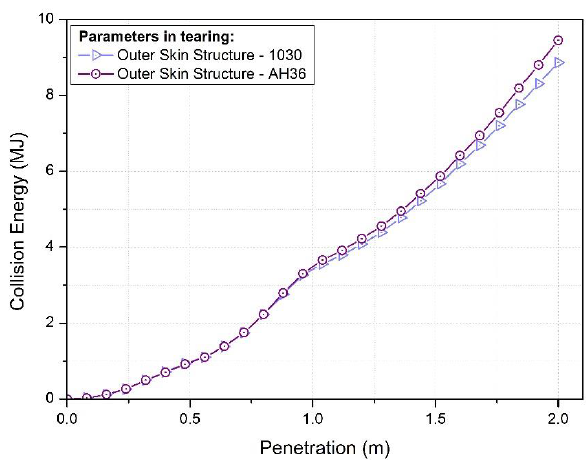
Figure 16: Displacement tendency of inner skin on 9 different loca- tions.